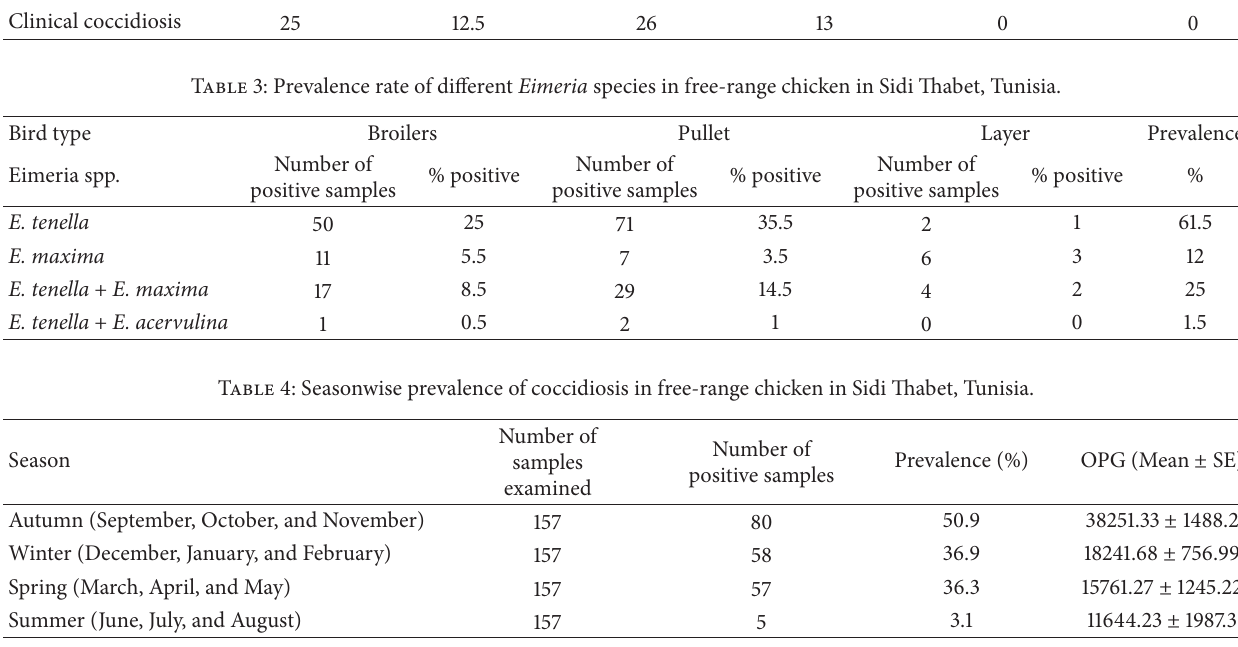
Table 2: Prevalence of subclinical and clinical coccidiosis in free-range chicken in Sidi Thabet, Tunisia. Broiler Pullet Layer Infection grade Number of Subclinical coccidiosis